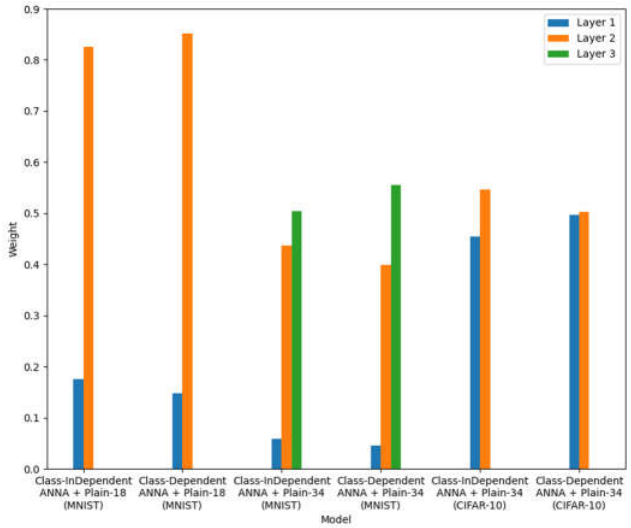
Figure 16. Layers’ relevance weights learned by ANNA approaches when applied to Plain-18 and